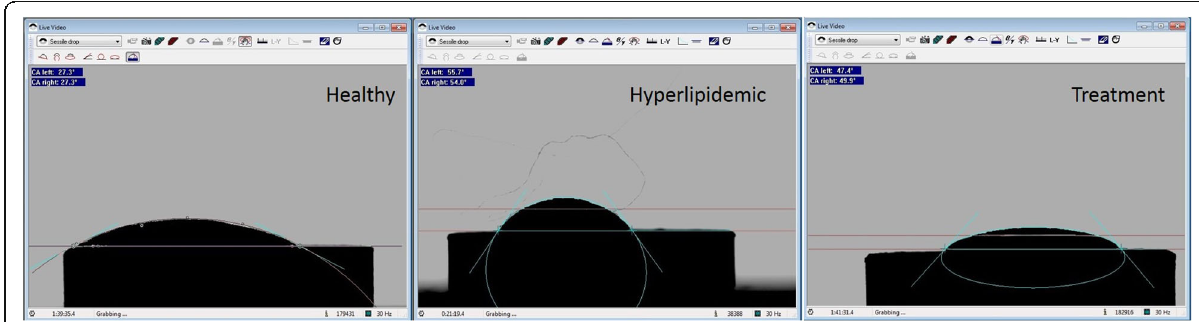
Fig. 4 Contact angle images of the same sample in healthy, hyperlipidemic, and treatment